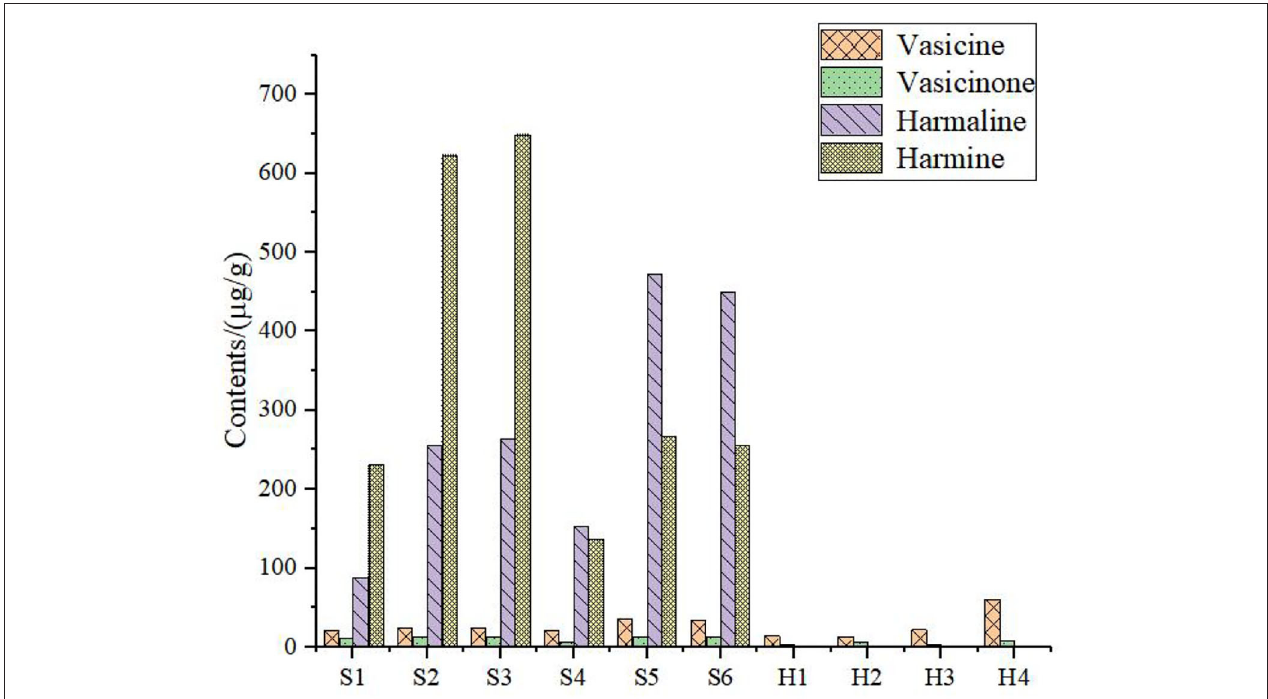
FIGURE 4 | Contents of four alkaloids in P. harmala L. S1–S6, the seeds; H1–H4, the aerial parts.